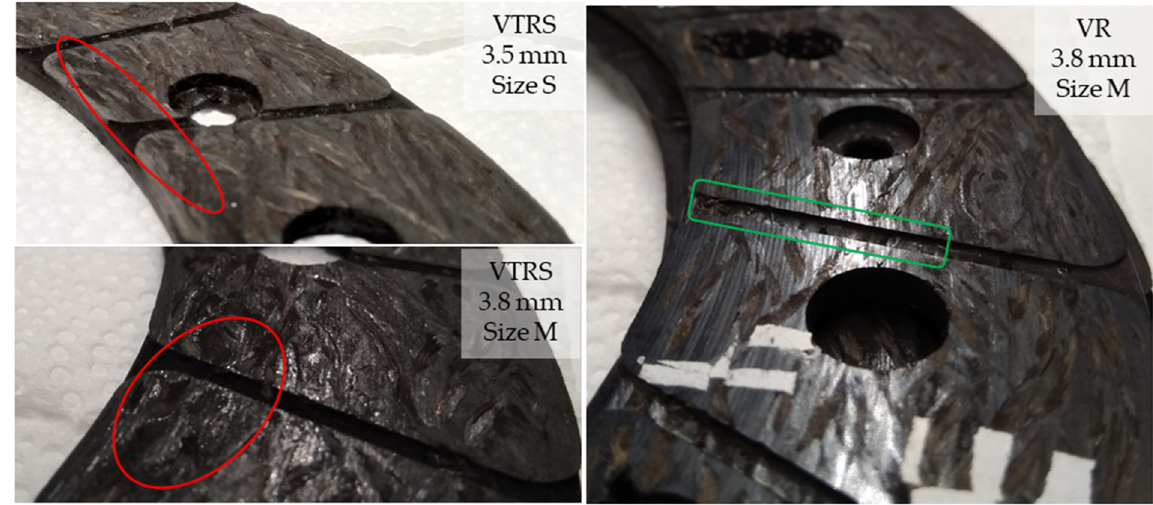
Figure 11. Visual inspection of surfaces after trend 1 (VTRS) and trend 2 (VR) tests. Radial and tangential direction surface roughness values decreased on the working diameter along the increasing applied energy scale, with some exceptions due to different parameters governing their application. Trends observed from wear results were present and Rmax values highlight them more significantly than Ra or Rz results: clutch killer low energy and mileage test effects were even more significant with increased Rmax values on both inner and working diameters in radial and axial direction, proving the theory of torn-up surfaces.